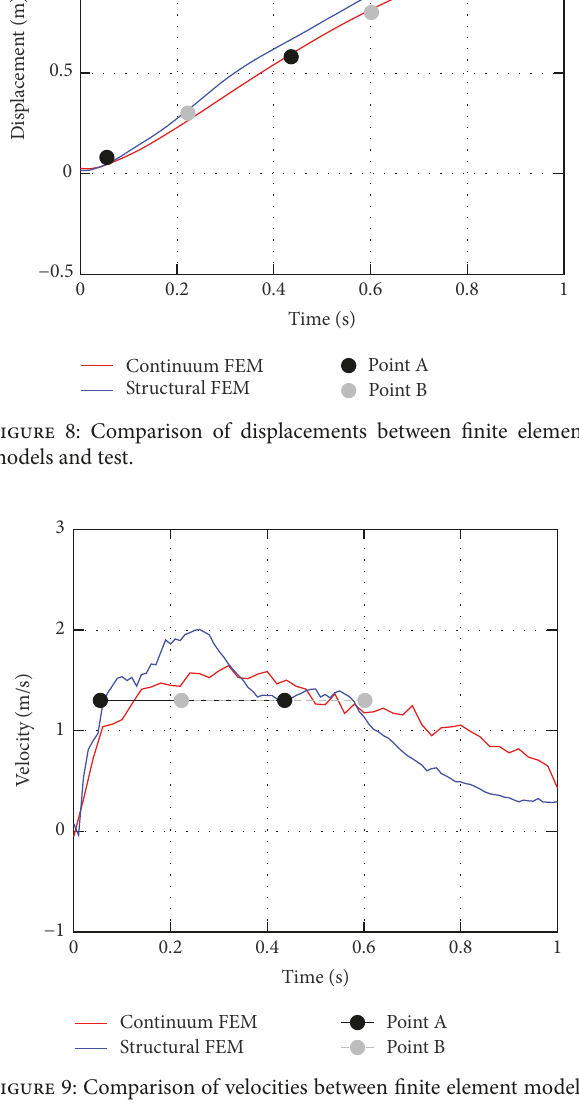
Figure 9: Comparison of velocities between finite element models and